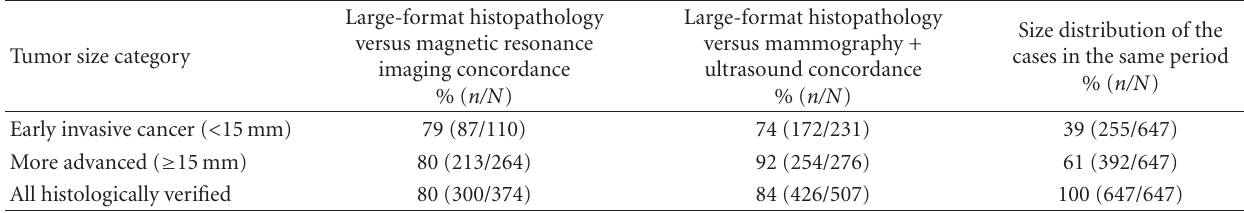
Tumor size category